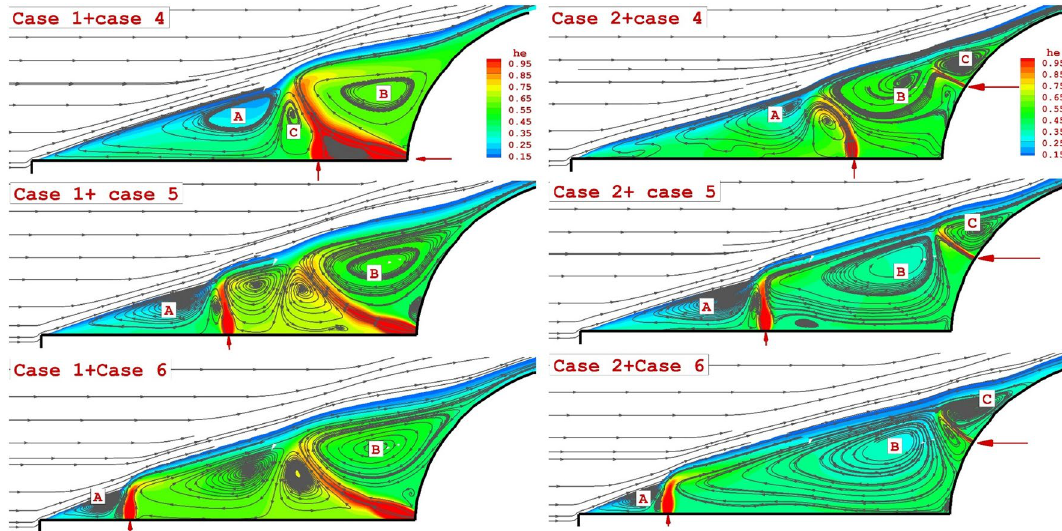
Figure 6. Effects of different arrangement of two helium jets (one lateral jet + one opposing jet) on the flow stream.